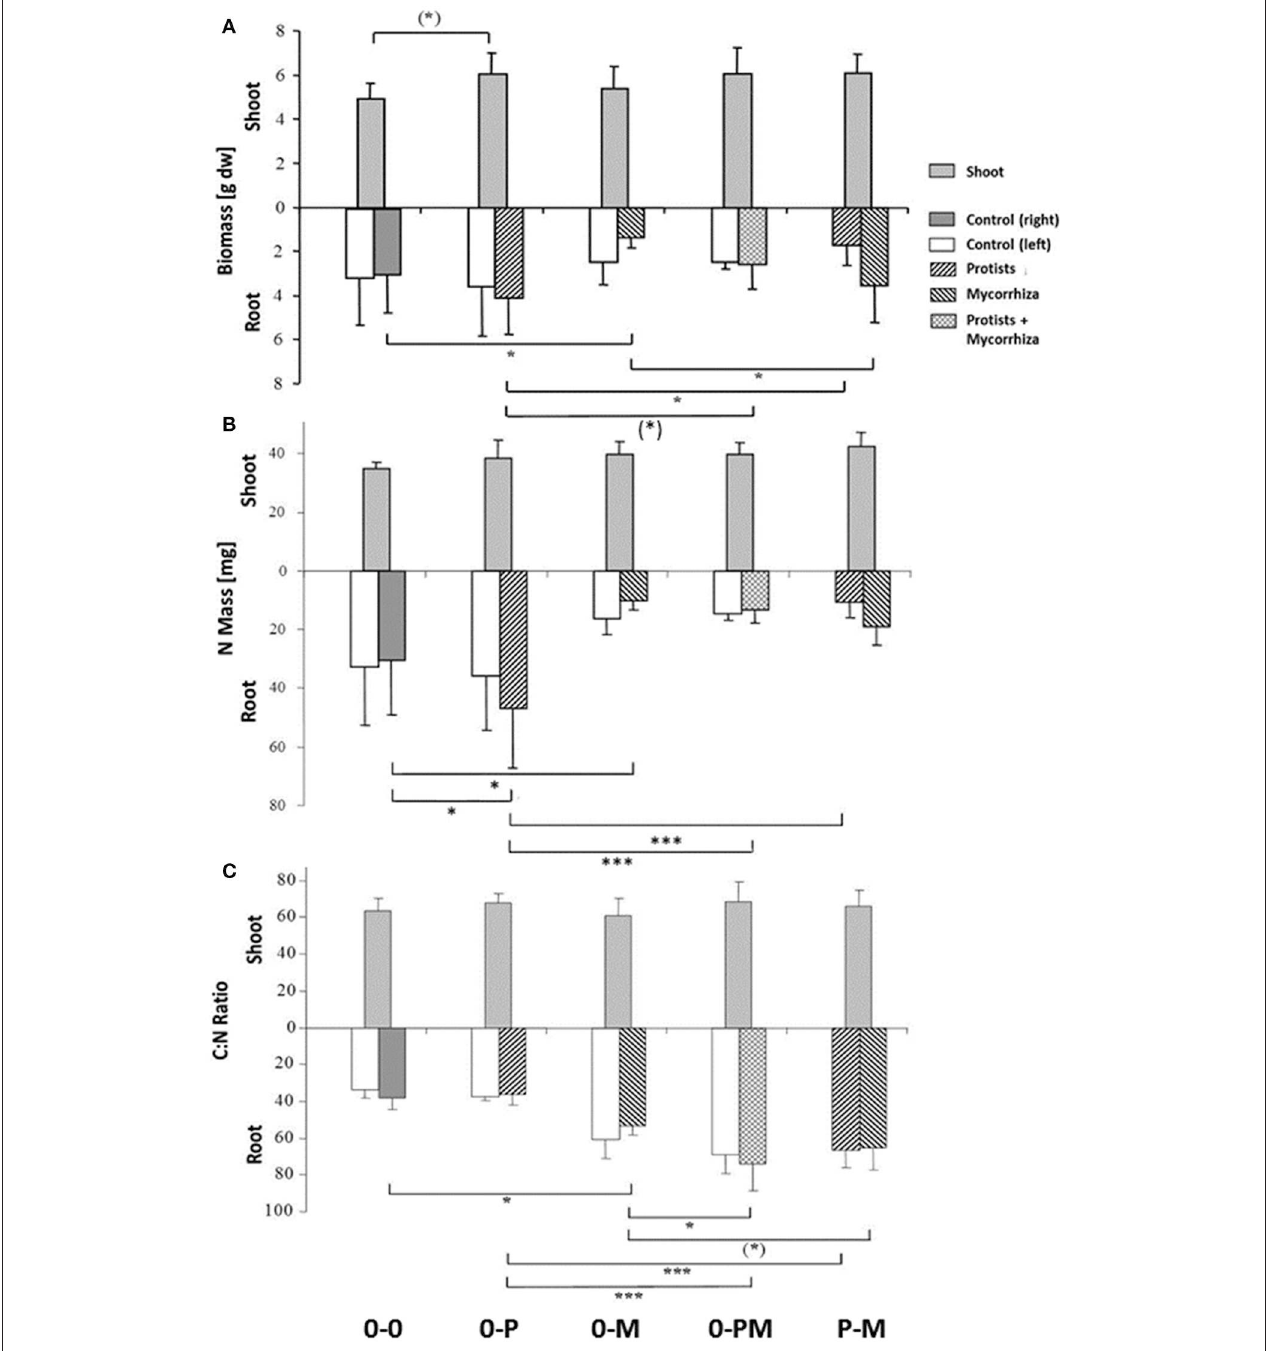
FIGURE 2 | Biomass (A) total N mass (mg) (B) and C:N mass ratio (C) of shoots and of roots of Triticum aestivum in both root chambers of control plants (0-0), plants treated with protists in the right root chamber (0-P), or treated with mycorrhiza in the right root chamber (0-M), or treated with protists and mycorrhiza together in the right root chamber (0-PM), or where the left and right root chambers were separately treated with protists and mycorrhiza (P-M). Means and standard deviation; horizontal lines denote significant contrasts with (*) p < 0.1, * p < 0.05, *** p < 0.001. was also significantly reduced as compared to the mycorrhiza 2.57 and 2.58-fold enhanced shoot-to-root N mass ratios in 0- PM and P-M treatments as compared to the control, respectively chamber of the 0-M treatment [from 0.75 to 0.60 mg g − 1 ; ( Figure 2B , Table 2 ). Interestingly, the root N concentration F (1,23) = 4.57; p = 0.043], suggesting N uptake by mycorrhiza of the protist + mycorrhiza chamber in the 0-PM treatment in PM ( Figure S3 ). Unexpectedly, total mass of root N in